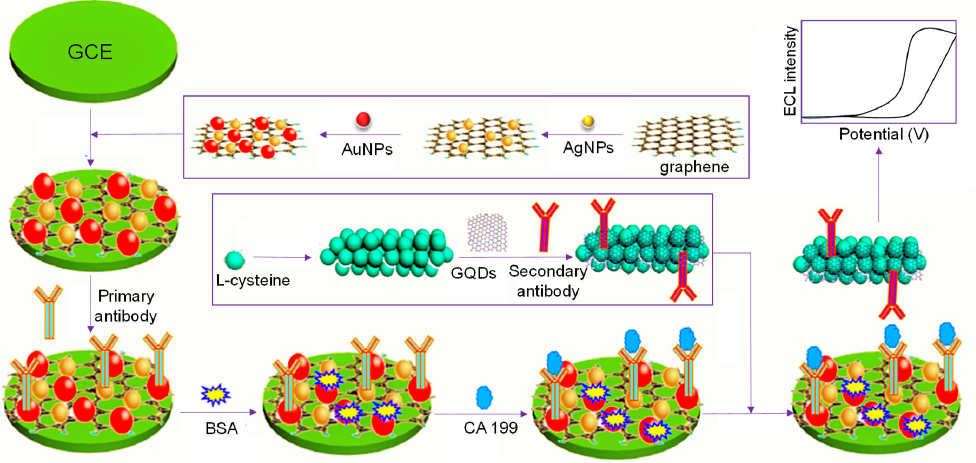
Figure 10. A step-wise developmental procedure of GQD-based sandwich-assay for carbohydrate antigen (CA) 199 [191].